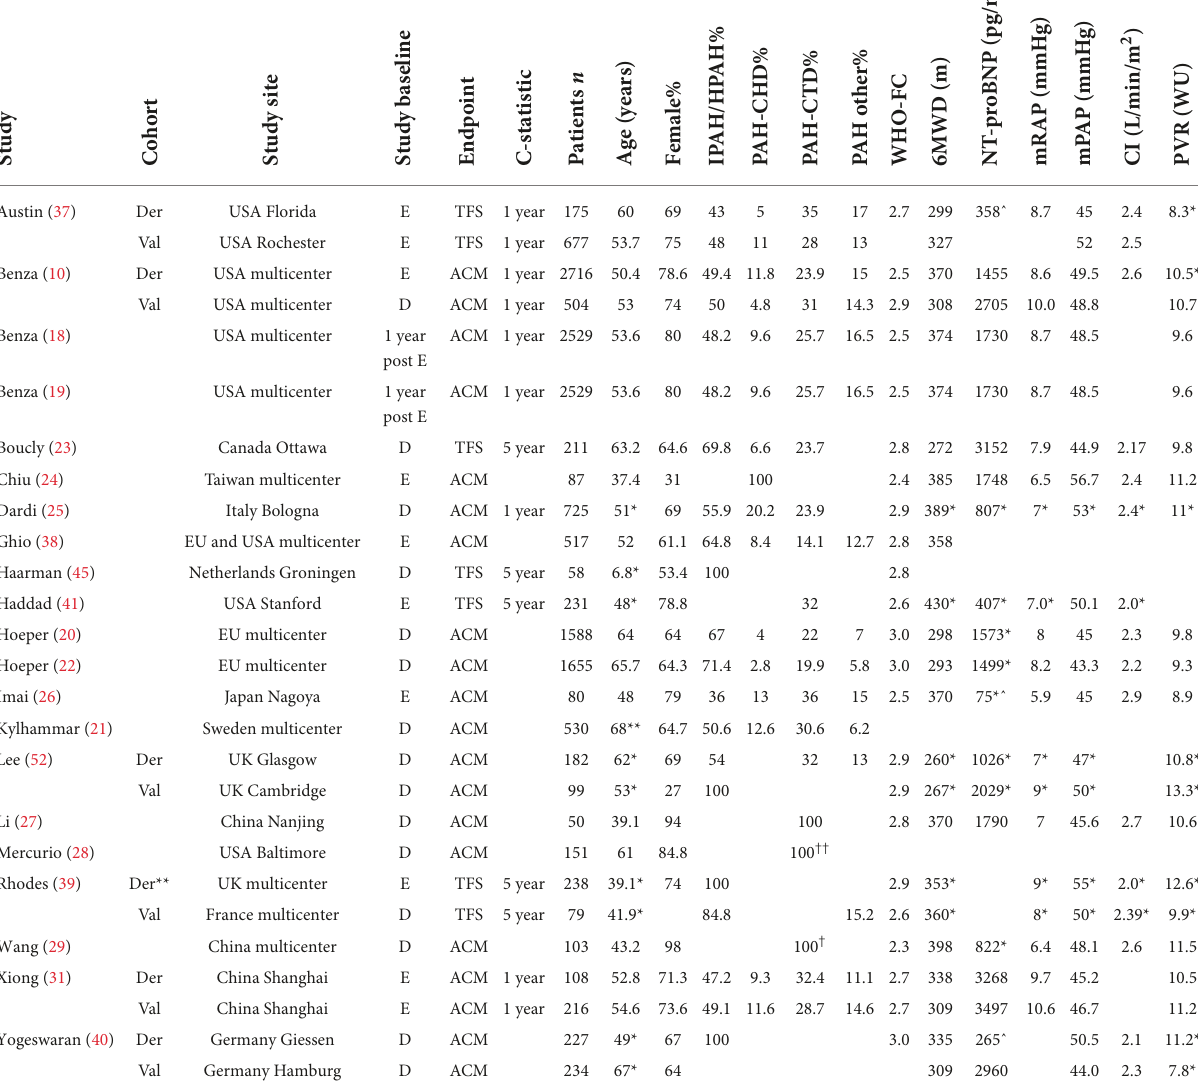
TABLE 1 Study characteristics of studies describing model